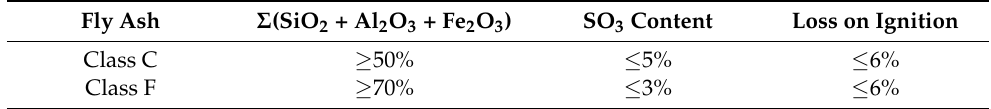
Table 1. ASTM C618-12a classification of fly ashes. Fly